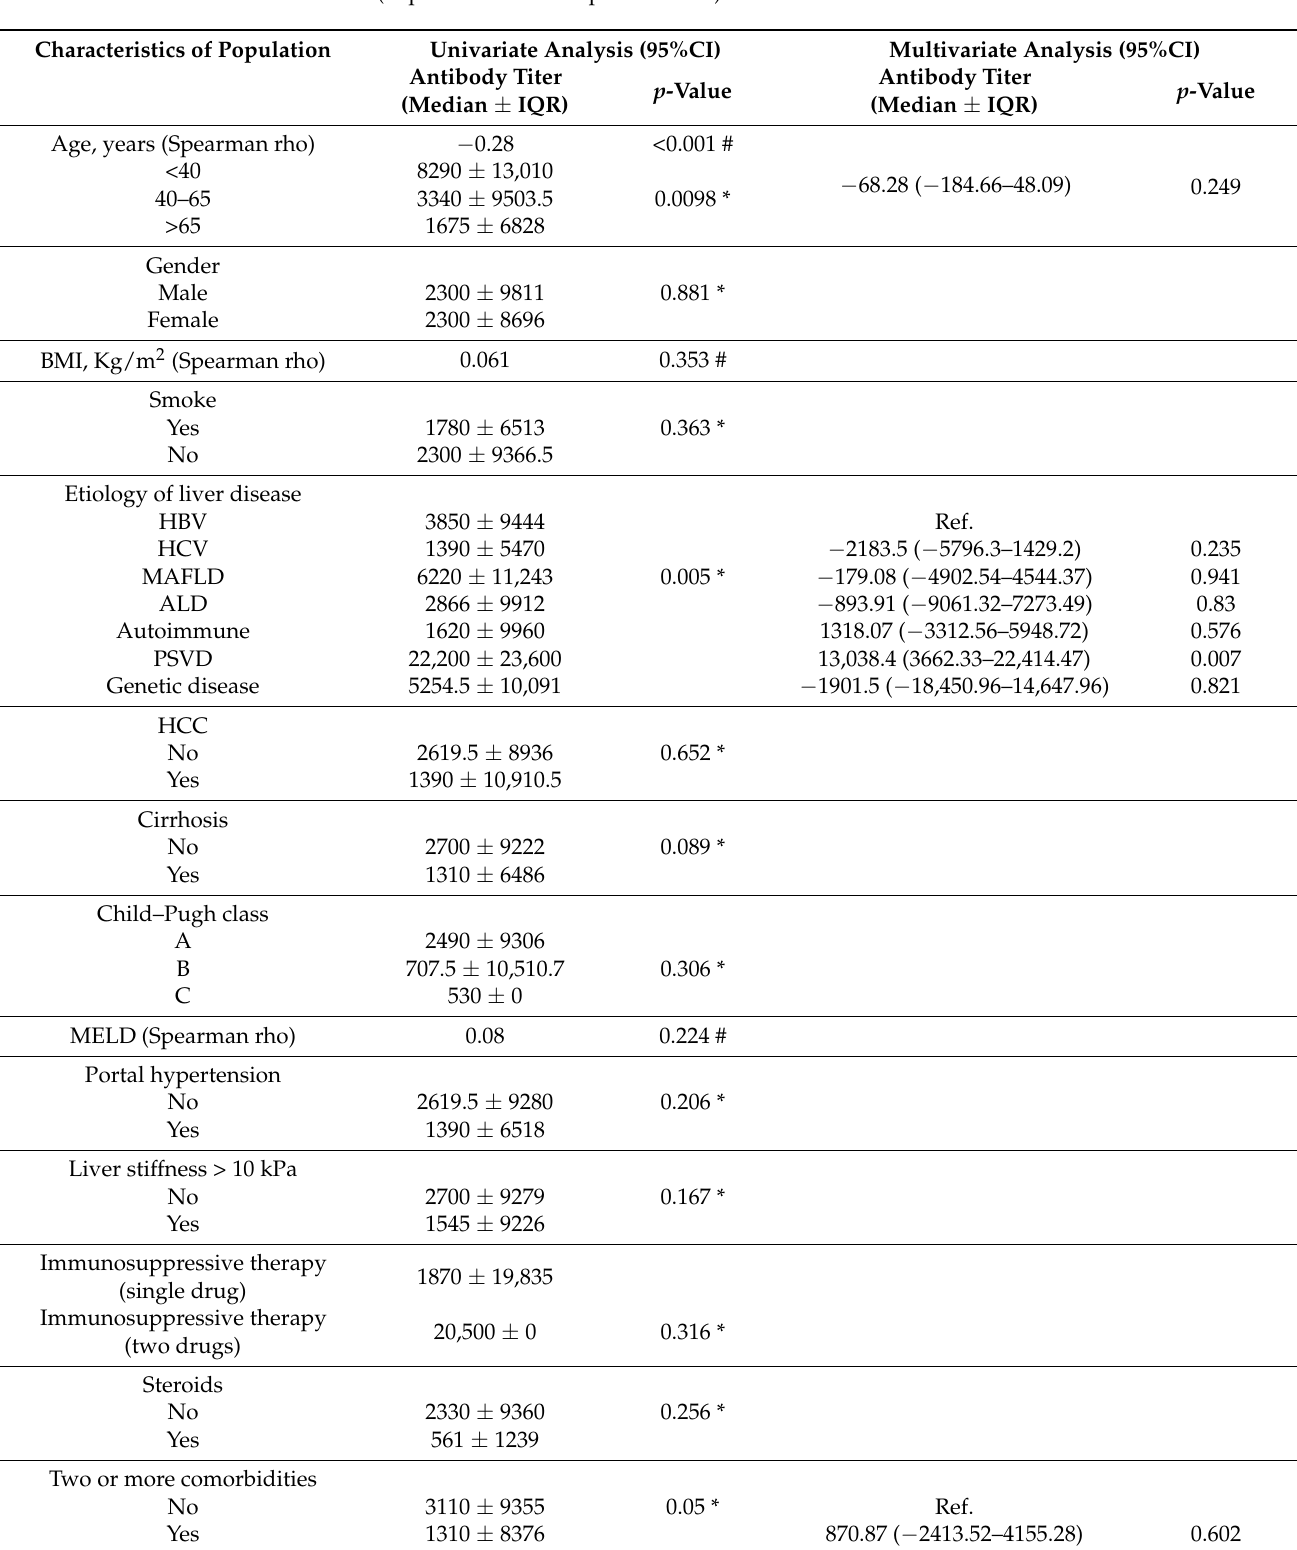
Table 2. Univariable and multivariable analysis on factors associated with positive serology to booster dose (dependent variable: positive